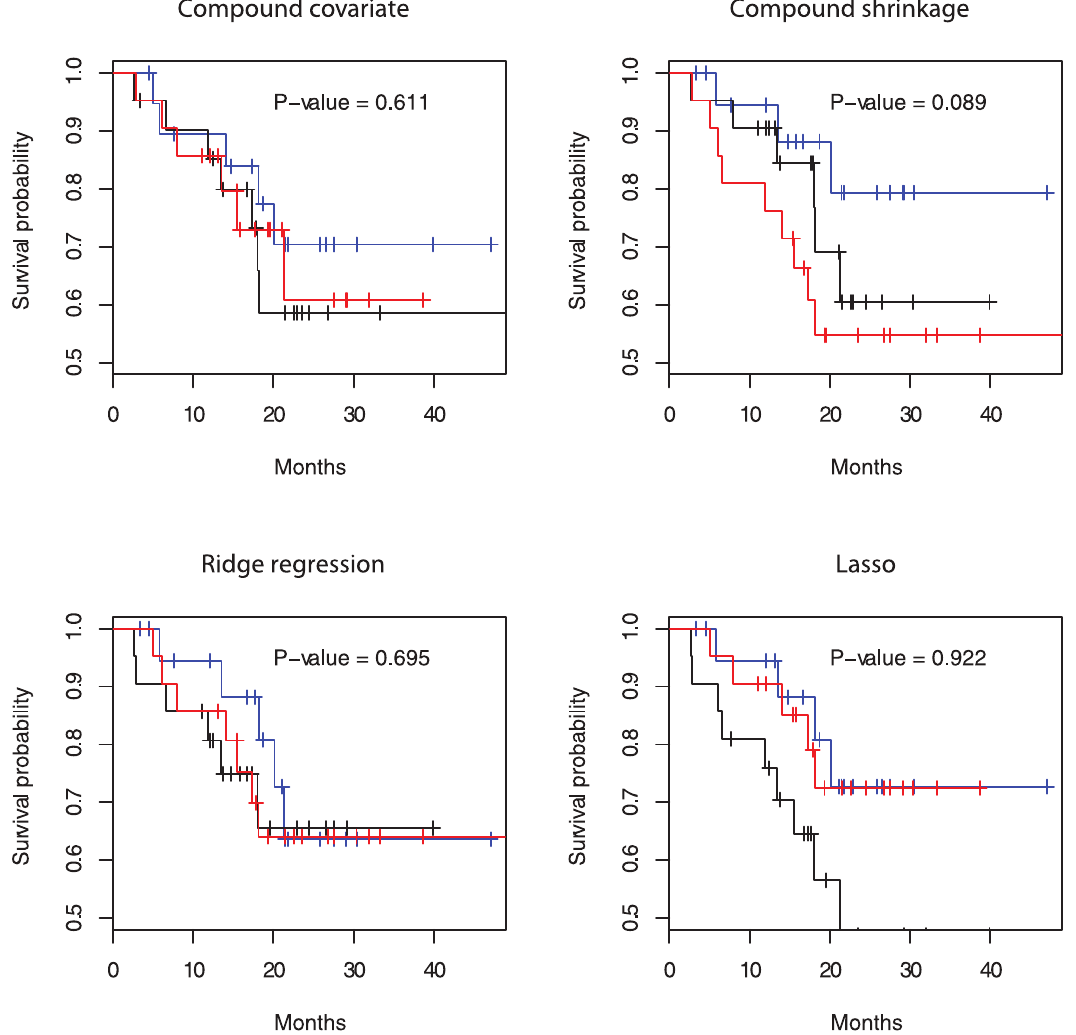
Figure 3. Kaplan-Meier curves for the 62 patients in the lung cancer data of Chen et al. [ 6 ] . Good (blue), medium (black), and poor (red) groups are determined by the tertile of the PI’s in the test dataset.